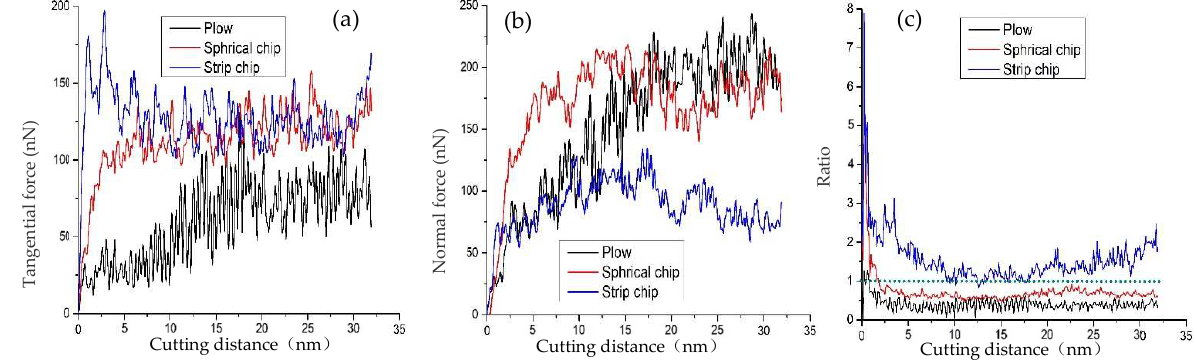
Figure 5. Change in tangential forces, normal forces, and friction coefficients at different chip states. ( a ) Change in tangential forces at different chip states; ( b ) change in normal forces at different chip states; and ( c ) change in ratio of tangential force to normal force at different chip states.